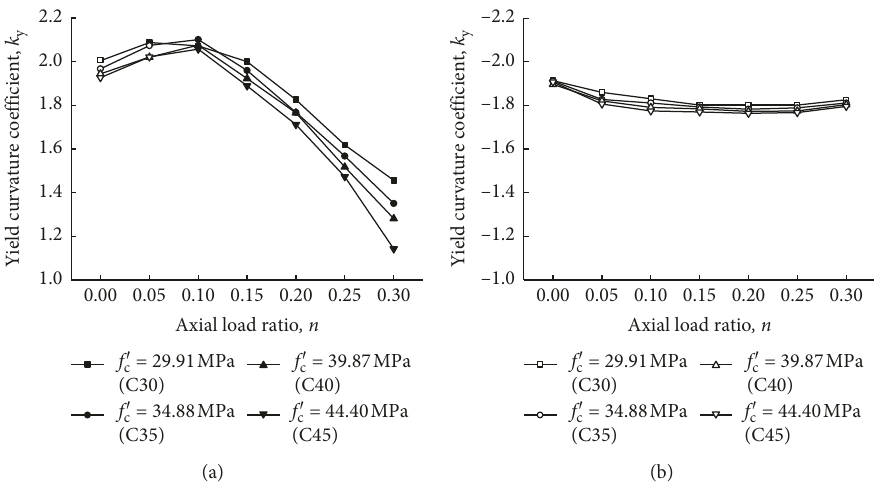
Figure 9: Variations in the yield curvature coefficient with the axial load ratio at different concrete strengths. (a) Flange in tension. (b) Flange in